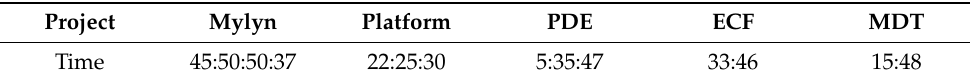
Table 5. The execution time of CERNN